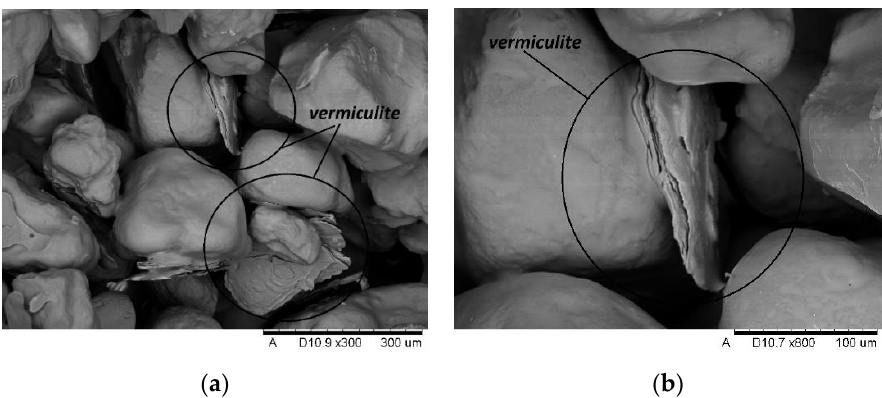
Figure 18. SEM imaging of moulding sand with vermiculite (V) after annealing at 800 °C: ( a ) magnification 300×; ( b ) magnification 800×.